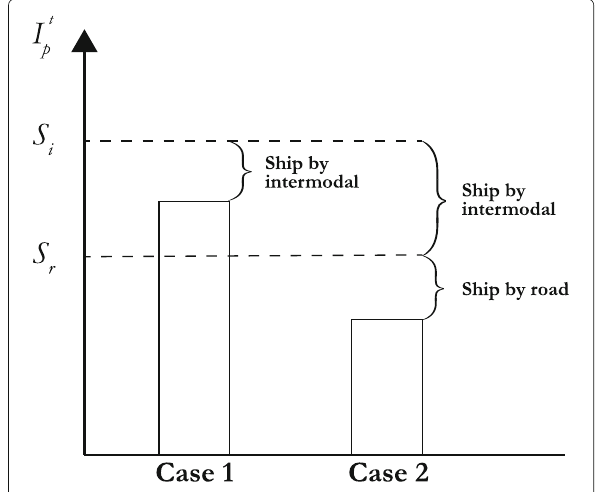
Fig. 3 When S r ≤ I t p < S i (case 1), only intermodal transport is used to ship Q t i = S i − I t p units (and Q t r = 0); when I t p < S r (case 2), an order of Q t r = S r − I t p units is shipped using road transport, and Q t i = S i − S r units are shipped via intermodal rail